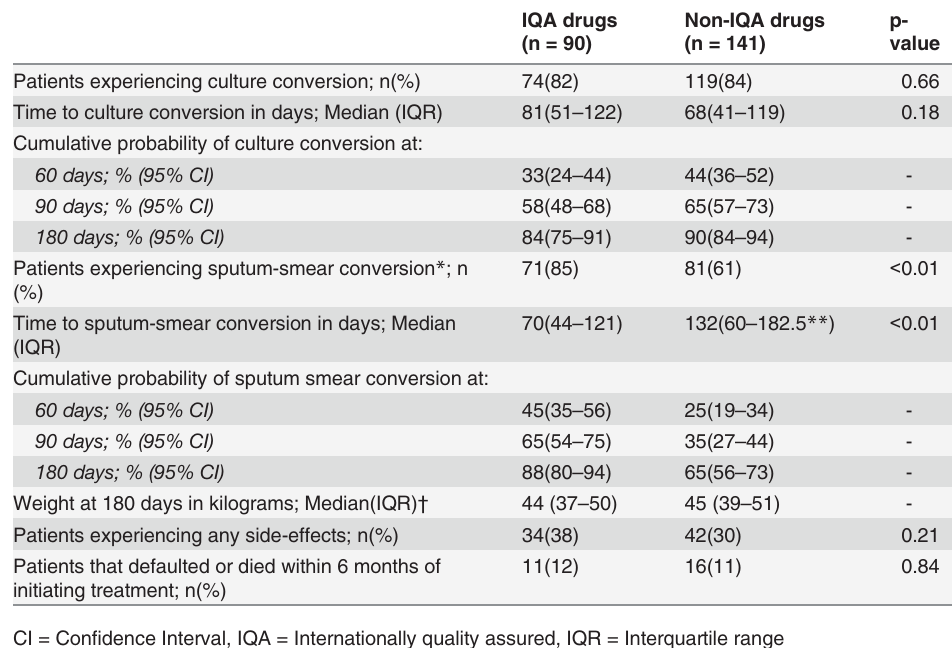
Table 2. Treatment success indicators by cohort (n =